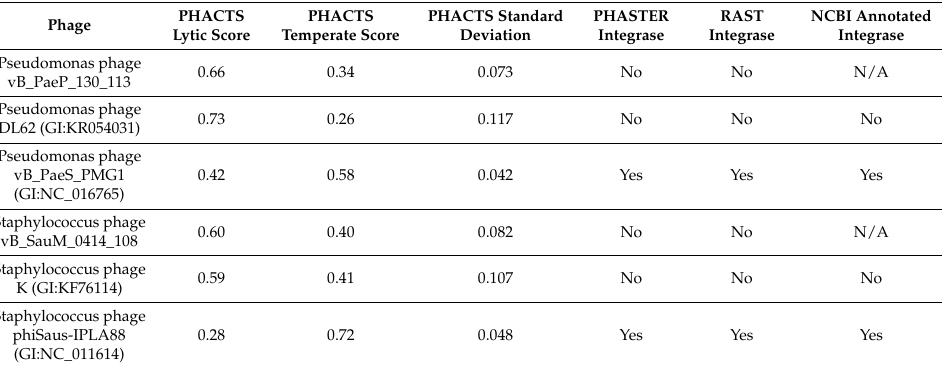
Table 4. Phage lifestyle